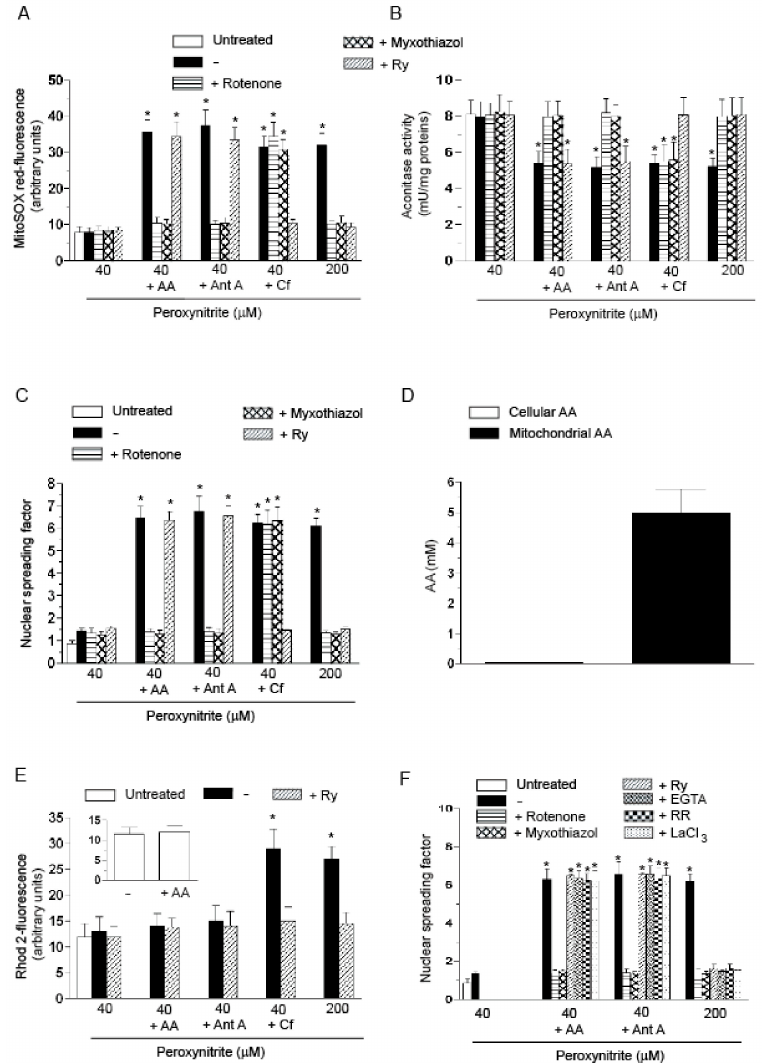
Figure 1. The enhancing effects of AA in U937 cells exposed to low concentrations of peroxynitrite: evidence for a Ca 2+ -independent mechanism. ( A – C ) The cells were treated as shown in the figure and then exposed for: 10 min ( A , B ); or 30 min ( C ) to the indicated concentrations of peroxynitrite. AA (3 µ M) was given to the cells 15 min prior to peroxynitrite. Pre-exposure to antimycin A (Ant A, 1 µ M), or Cf (10 mM), was instead of only 5 min. In some experiments, rotenone (0.5 µ M), myxothiazol (5 µ M) or Ry (ryanodine) (20 µ M) were added to the cells 5 min prior addition of AA, Ant A or Cf. After treatments, the cells were analyzed for: MitoSOX red-fluorescence ( A ); aconitase activity ( B ); and DNA strand scission ( C ); ( D ) the cells were exposed for 15 min to AA and immediately analyzed for their cellular and mitochondrial content of the vitamin; ( E ) Rhod 2-AM (acetoxymethyl) pre-loaded cells were treated for 10 min, as indicated in the figure, and analyzed as detailed in the Materials and Methods Section. The inset shows the Rhod 2-fluorescence response observed in cells exposed for 15 min to 0 or AA; ( F ) cells were permeabilized with digitonin and exposed for 10 min to the indicated concentrations of peroxynitrite alone or associated with rotenone, myxothiazol, Ry, EGTA (ethylene glycol-bis( β -aminoethylether)- N , N , N (cid:48) , N (cid:48) -tetraacetic acid) (10 µ M), RR (ruthenium red) (200 nM) or LaCl 3 (100 µ M). In some experiments, the cells were exposed to AA prior to permeabilization. In other experiments, the cells were supplemented with Ant A immediately after permeabilization. Results represent the means ± SD calculated from at least three separate experiments. * p < 0.001 as compared to untreated cells (one-way ANOVA followed by Dunnett’s